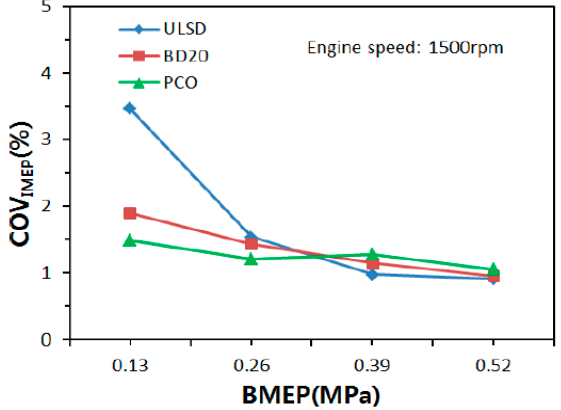
Figure 15. The coefficient of variation in indicated mean effective pressure of biodiesel fuels at various brake mean effective pressures. COV IMEP : coefficient of variation in indicated mean effective pressure; BMEP: brake mean effective pressure; ULSD: ultra-low-sulfur diesel; PCO: pure canola oil.